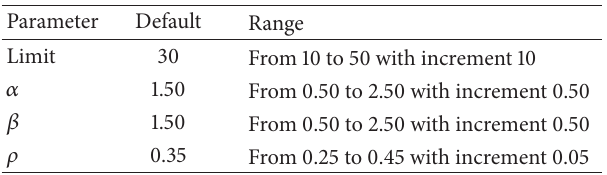
Table 2: The used test cases. Table 3: The tuned